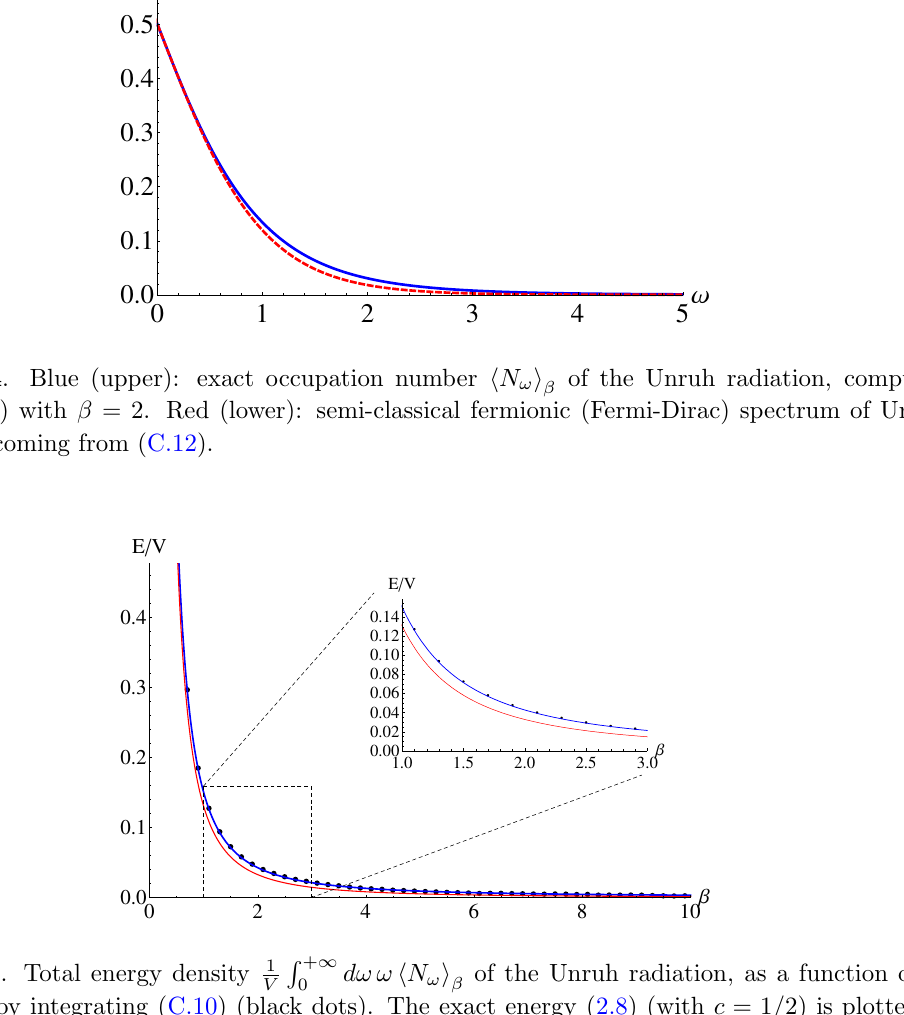
R + 1 Figure 15 . Total energy density 1 d! ! h N ! i of the Unruh radiation, as a function of (cid:12) , (cid:12) V 0 computed by integrating (C.10) (black dots). The exact energy (2.8) (with c = 1 = 2) is plotted as a blue line (top). The semi-classical energy (2.7) is plotted as a red line (bottom), computable by integrating (C.12). The inset shows in more detail the match at the exact level, and the approximation made by taking the semi-classical